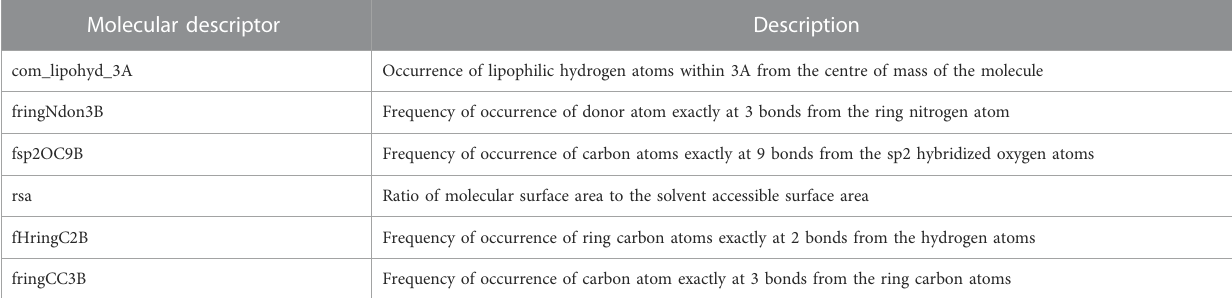
TABLE 1 Different molecular descriptors present in the developed QSAR model and their description.